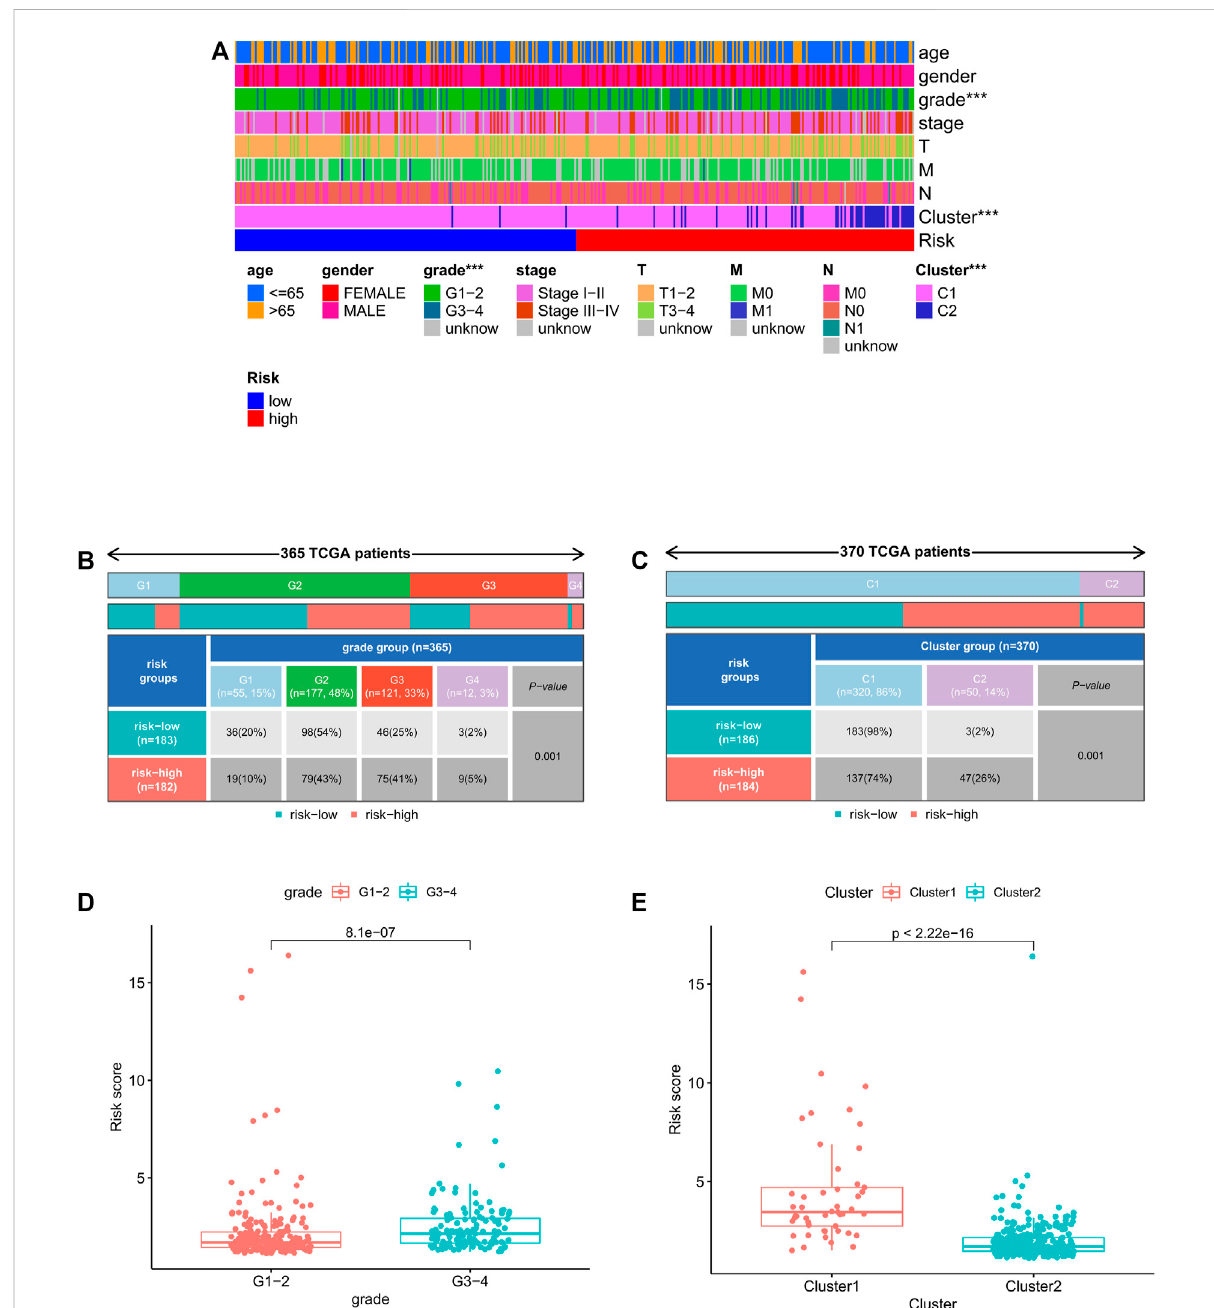
FIGURE 7 Relationshipbetweenriskscoreandclinicopathologicfeatures. (A)